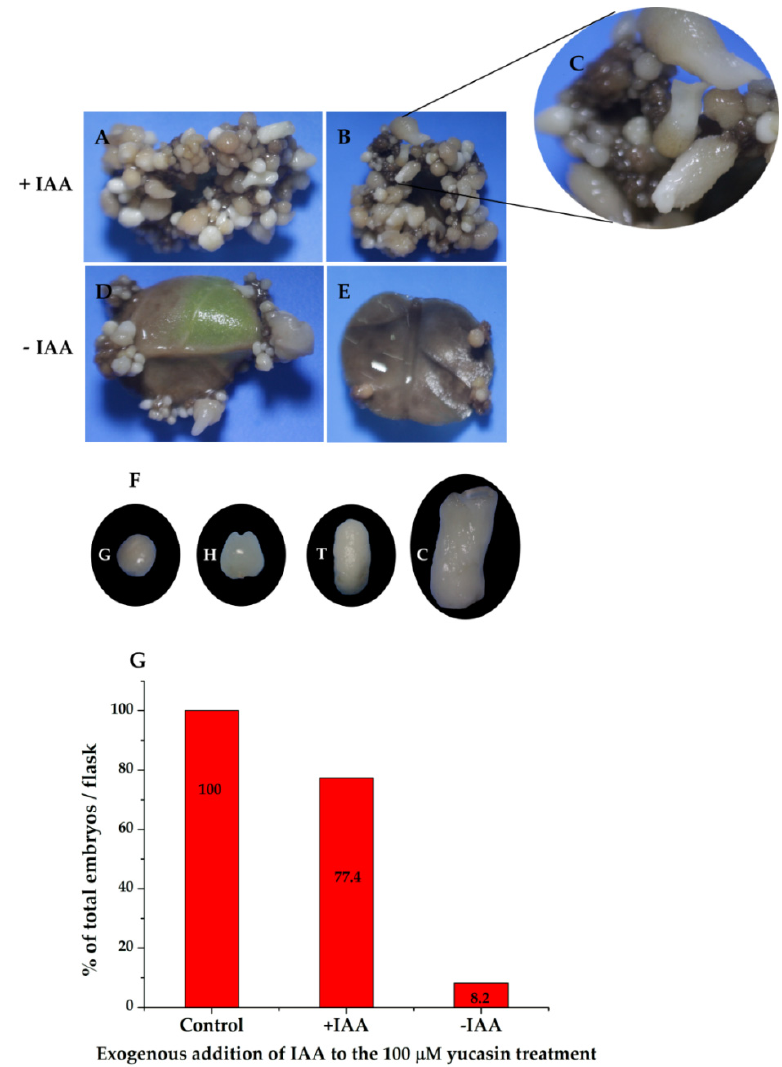
Figure 11. The exogenous addition of IAA restored somatic embryogenesis in explants previously treated with 100 µ M yucasin. ( A ) , ( B ) , Restoration of somatic embryogenesis by exogenous application of IAA to explants treated with 100 µ M yucasin. ( C ) , Close-up shows the presence of somatic embryos at different stages of development. ( D ) , ( E ) , Explants in the presence of 100 µ M yucasin. ( F ) , Different development stages of somatic embryos after four weeks in the presence of exogenous IAA. ( G ) , The total percentage of embryos formed in flasks with and without IAA.